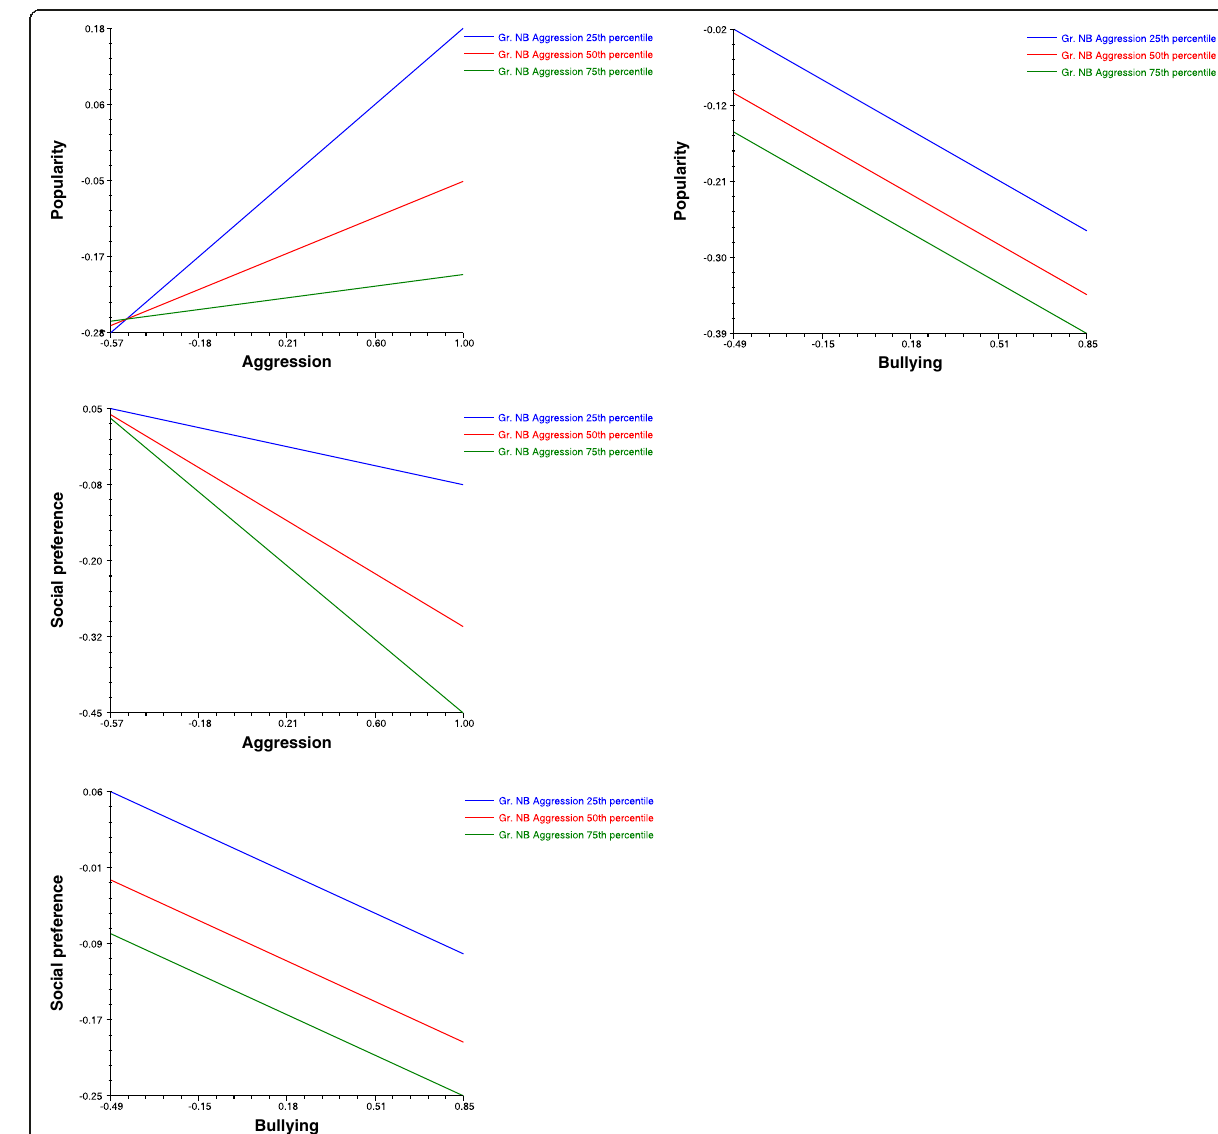
Fig. 1 Slopes of aggression ( left ) and bullying ( right ) regressed on popularity ( upper panel ) and social preference ( lower panel ), by different levels of group normative beliefs about